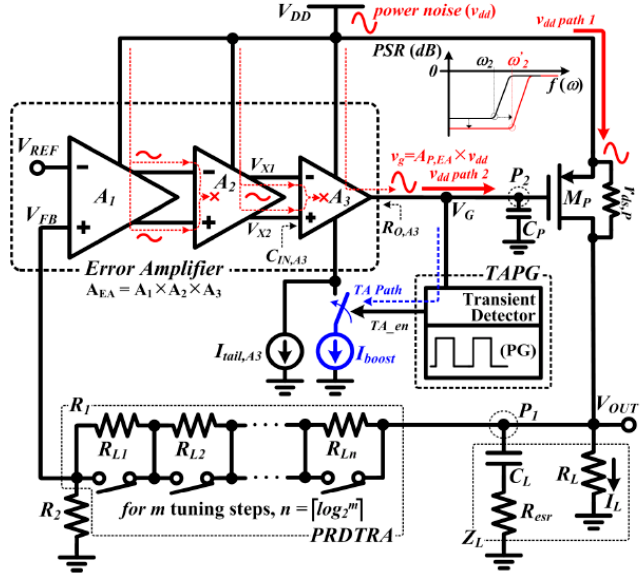
Figure 21. Multistage EA and PRDTRA-Based LDO [49].